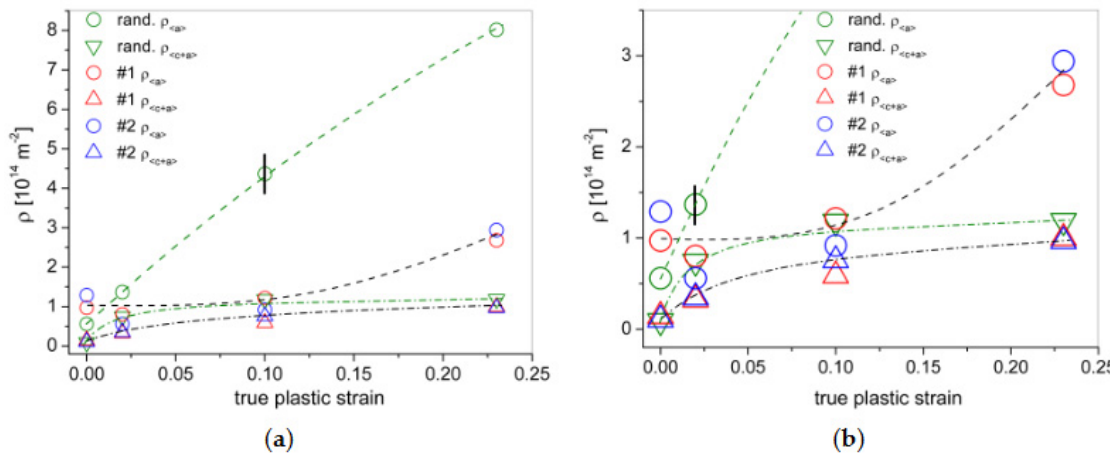
Figure 10. ( a ) Dislocation densities in the two major and random texture components of dislocations with (cid:104) a (cid:105) and (cid:104) c + a (cid:105) type Burgers vectors. ( b ) Enlarged part of the lower dislocation density range for better